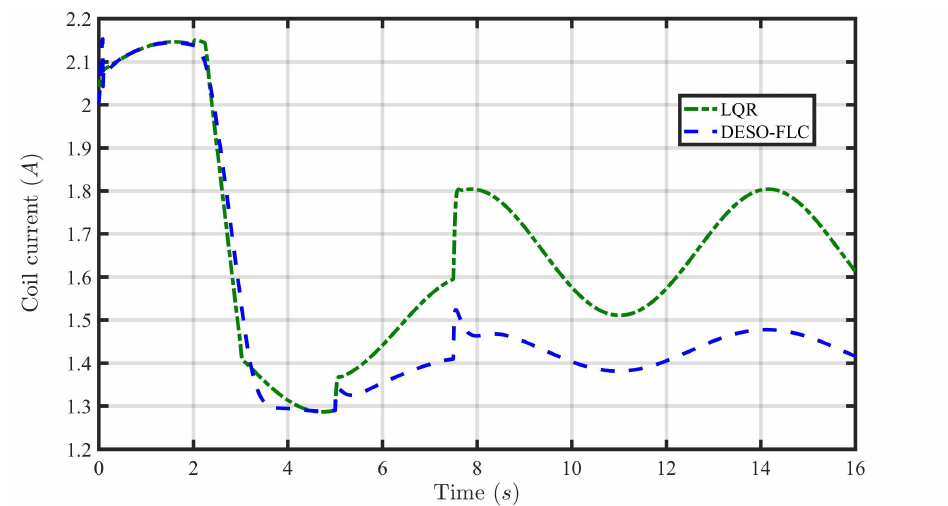
Figure 15. Response of the coil current ( x 3 ) in the presence of payload disturbances and parametric uncertainties.